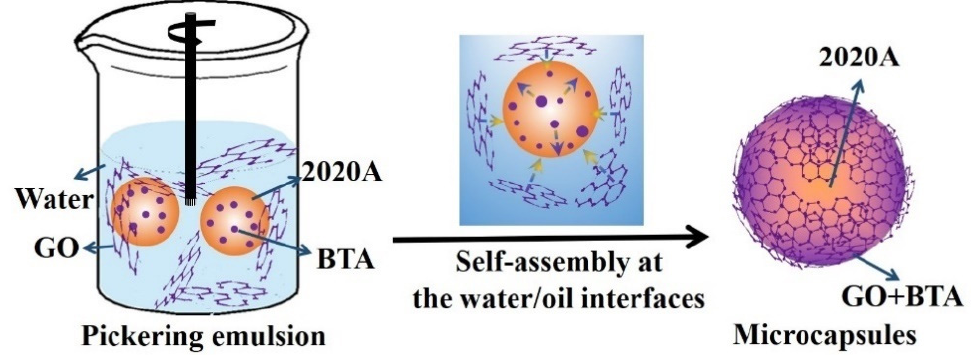
Figure 4. The formation schematics of the GO microcapsules.